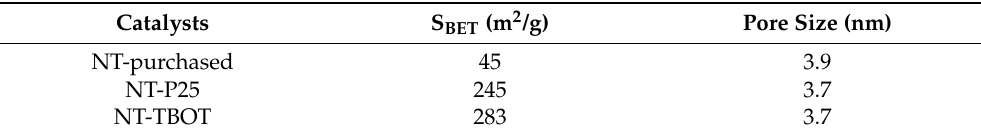
Figure 4. N 2 adsorption–desorption isotherms of catalysts. Table 1. Physical